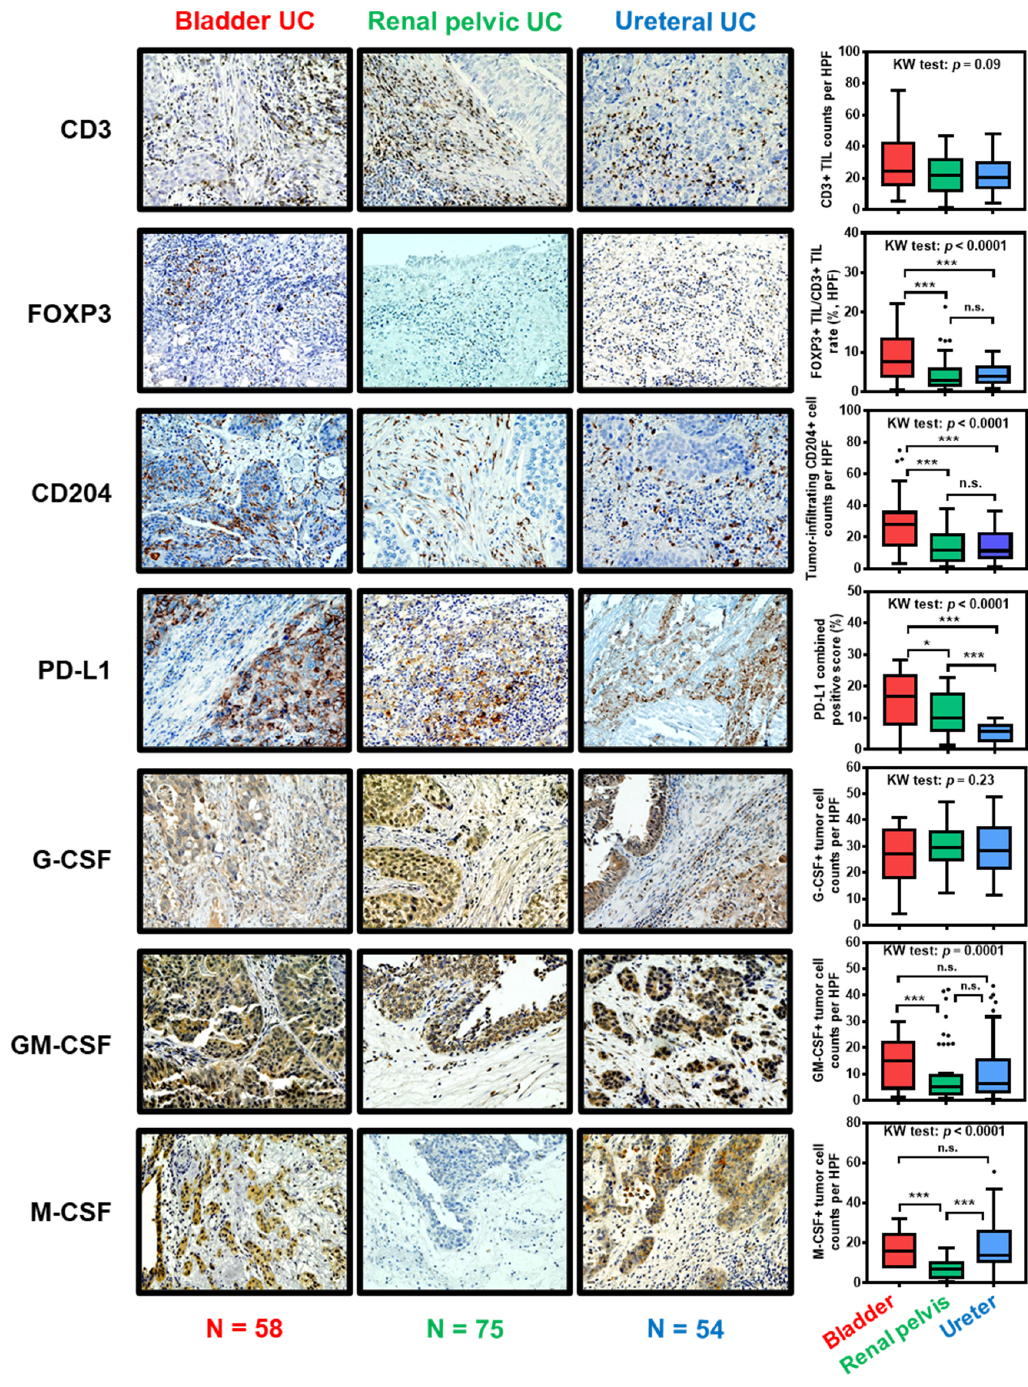
Figure 2. Difference in tumor immune microenvironments in urothelial carcinoma: comparison of primary tumor origins. The left panels are representative images of immunohistochemical staining of seven immune-related markers using surgically resected formalin-fixed paraffin-embedded specimens. Data were expressed by box-and-whisker plots, in which the outliers are indicated as dots, and compared using the Kruskal-Wallis (KW) test, followed by the post hoc test (Dunn test). * p < 0.05, *** p < 0.01, n.s., not significant. Abbreviations: UC, urothelial carcinoma; TIL, tumor-infiltrating leukocyte; HPF, high power field (magnification, ×400); PD-L1, programmed death-ligand 1; G-CSF, granulocyte colony-stimulating factor; GM-CSF, granulocyte-macrophage colony-stimulating factor; M-CSF, macrophage colony-stimulating factor.